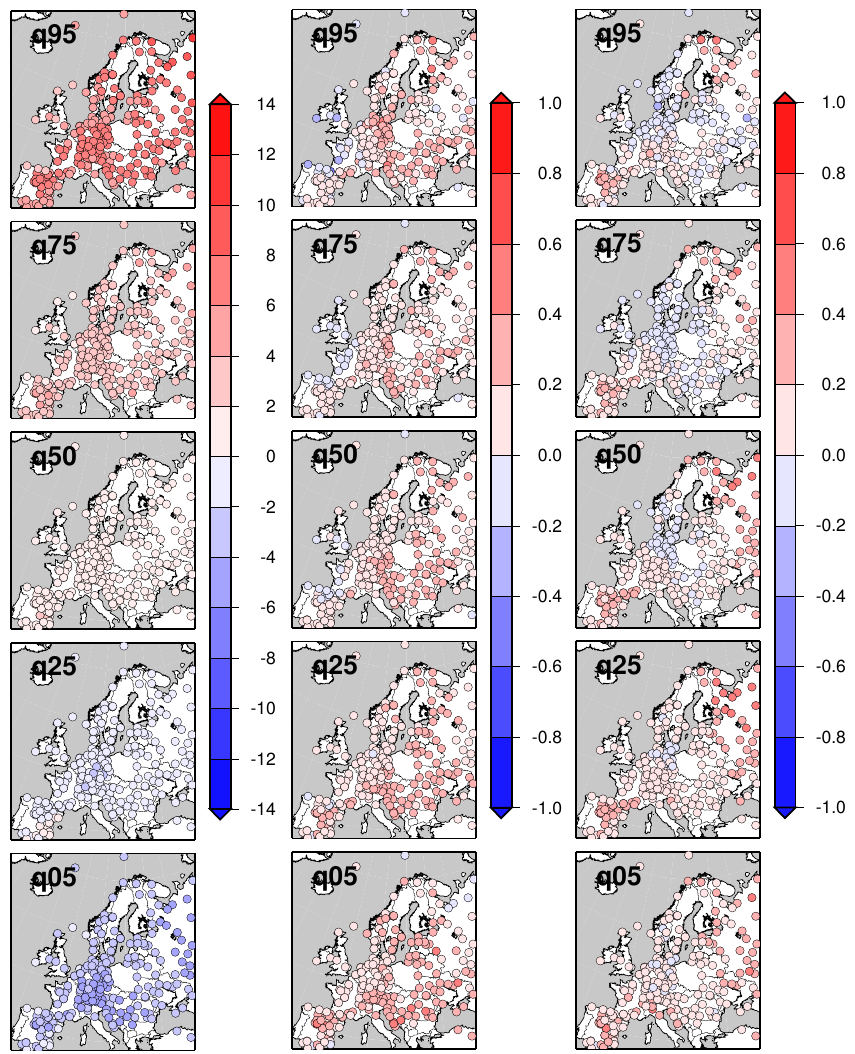
Fig. 3. Left column: 5th, 25th, 50th, 75th and 95th quantiles of summer temperature anomalies in Europe from the ECA&D set (in ◦ C). Central column: differences of quantiles between observed and simulated temperature anomalies with “static” weather generator. Right column: differences of quantiles between observed and simulated temperature anomalies with “dynamic” weather generator.